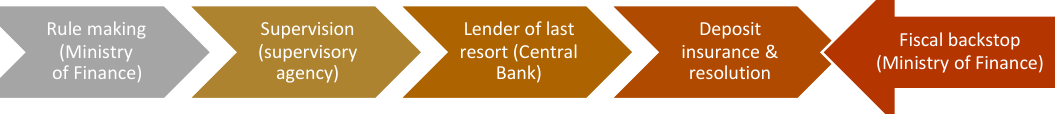
Figure 1. Governance framework of the European Banking Union